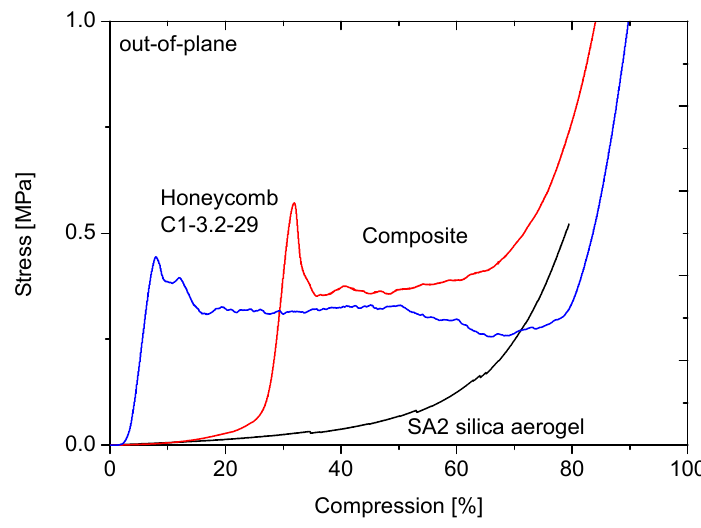
Figure 16. Compression curves of SA2 with C1-3.2-29 out-of-plane.